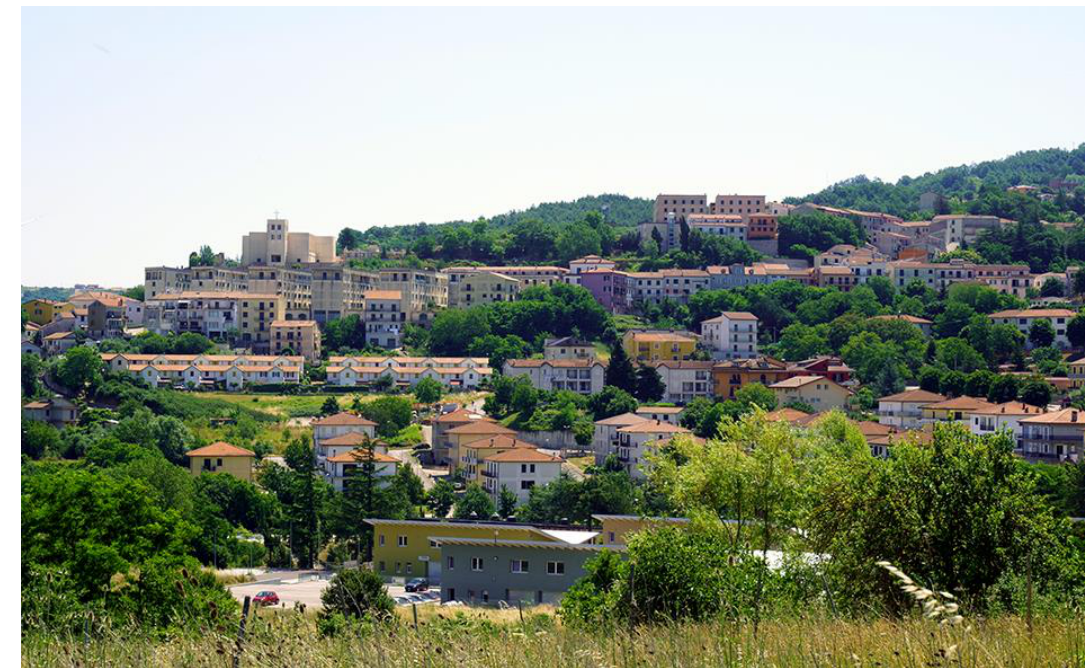
Figure 100. Teora: panorama of the reconstructed village (photos by [35,36]).